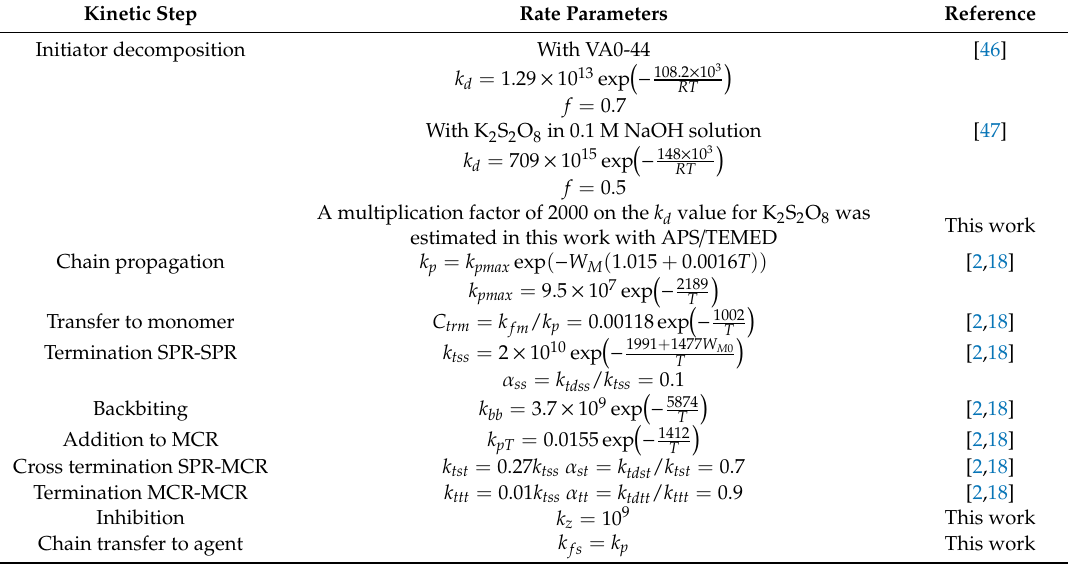
Table 4. Reference set of rate parameters considered in the kinetic modeling of the crosslinking polymerization of acrylamide (AAm) with methylene bisacrylamide (MBAm). Kinetic